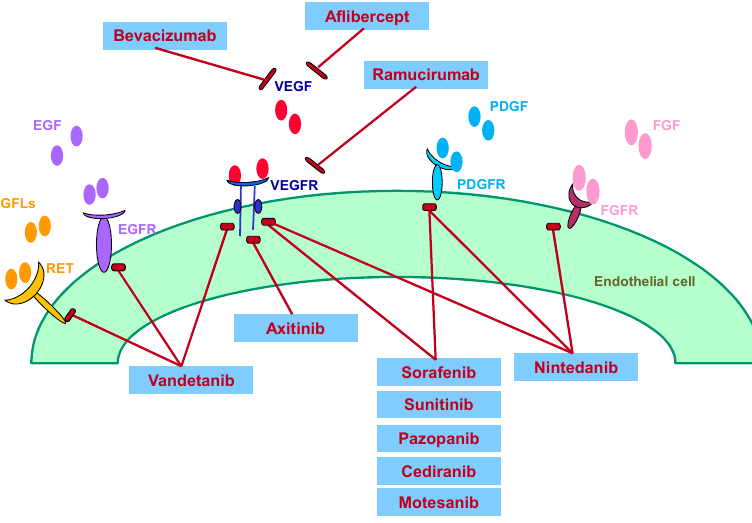
Figure 1. Mechanisms of action of angiogenesis inhibitors targeting VEGF, EGF, PDGF, FGF, RET and their receptors for suppressing angiogenesis. VEGF: vascular endothelial growth factor; EGF: epidermal growth factor; PDGF: placenta-derived growth factor; FGF: fibroblast growth factor; RET: REarranged during Transfection (gene).